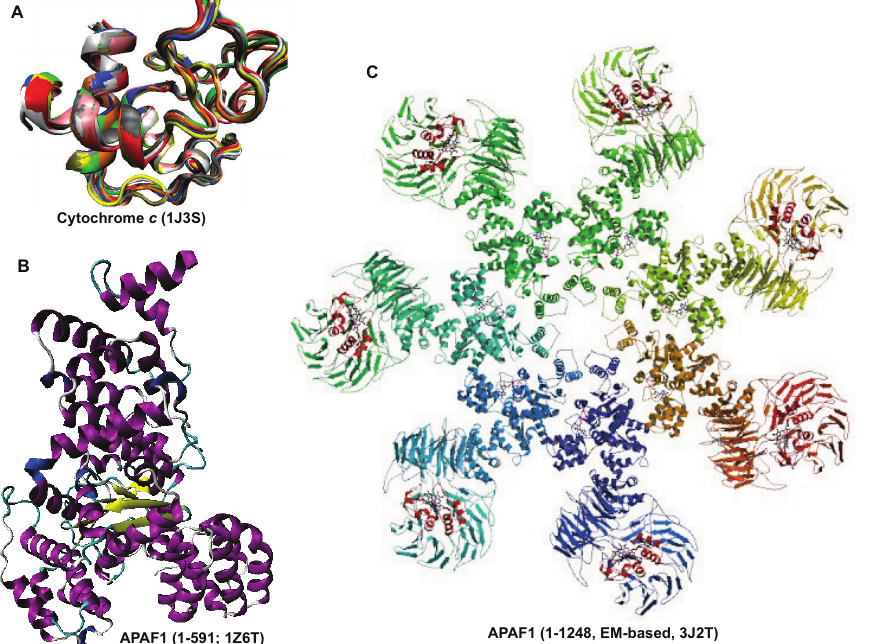
Figure 13. Structural characterization of human proteins involved in the p53-mediated apoptotic signaling pathways: group III. A . Cytochrome c (PDB ID: 1J3S); B . APAF-1 (Residues 1–591; PDB ID: 1Z6T); C . APAF-1 (PDB ID: